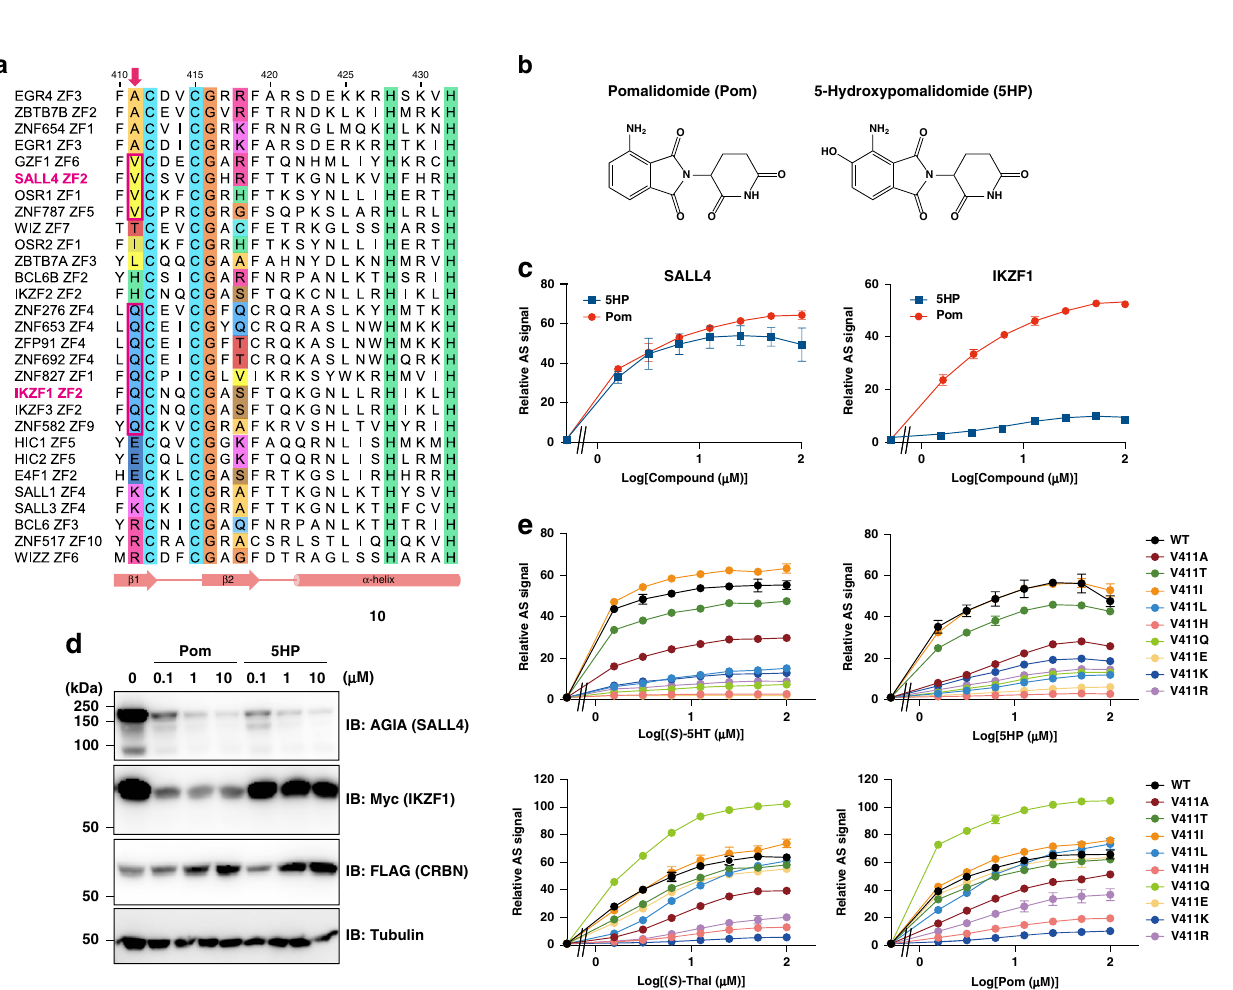
Fig. 5 CRBN-binding selectivity is affected by the V411 residue in SALL4. a Sequence alignment of SALL4 ZF2 and other C2H2 ZF domains according to the binding capacity of pomalidomide-engaged CRBN 24 . Residues conserved in the C2H2 ZF domains are shaded in cyan (Cys), orange (Gly), or lime (His). Arrow indicates the second residue of β -hairpin structure in C2H2 ZF-type neosubstrates. Numbers correspond to SALL4 ZF2. b Chemical structures of pomalidomide (Pom) and 5-hydroxypomalidomide (5HP). c Dose-dependent interaction of CRBN with SALL4 (left) and IKZF1 (right), as observed with the titration of racemate, Pom, and 5HP in the AS-based assay. AS signals are expressed as the luminescence signal relative to the luminescence signal of DMSO, which is considered equal to one. Data are presented as mean values± SD ( n = 3 independent experiments). d Comparison of Pom- or 5HP- dependent degradation of SALL4 and IKZF1. The experiment was repeated three times independently with similar results. e The effect of V411 mutation in SALL4 on the CRBN interaction mediated by ( S )-thalidomide (Thal), ( S )-5HT, Pom, or 5HP. AS signals are expressed as the luminescence signal relative to the luminescence signal of DMSO, which is considered equal to one. Data are presented as mean values ± SD ( n = 3 independent